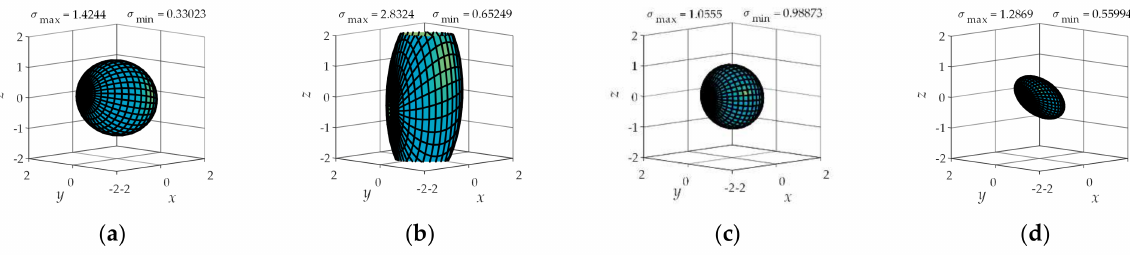
Figure 19. Manipulability ellipsoid of 5 R a 1 P in the sagittal plane. ( a ) β = 30 ◦ ; ( b ) β = 60 ◦ ; ( c ) β = 90 ◦ ; ( d ) β = 120 ◦ .